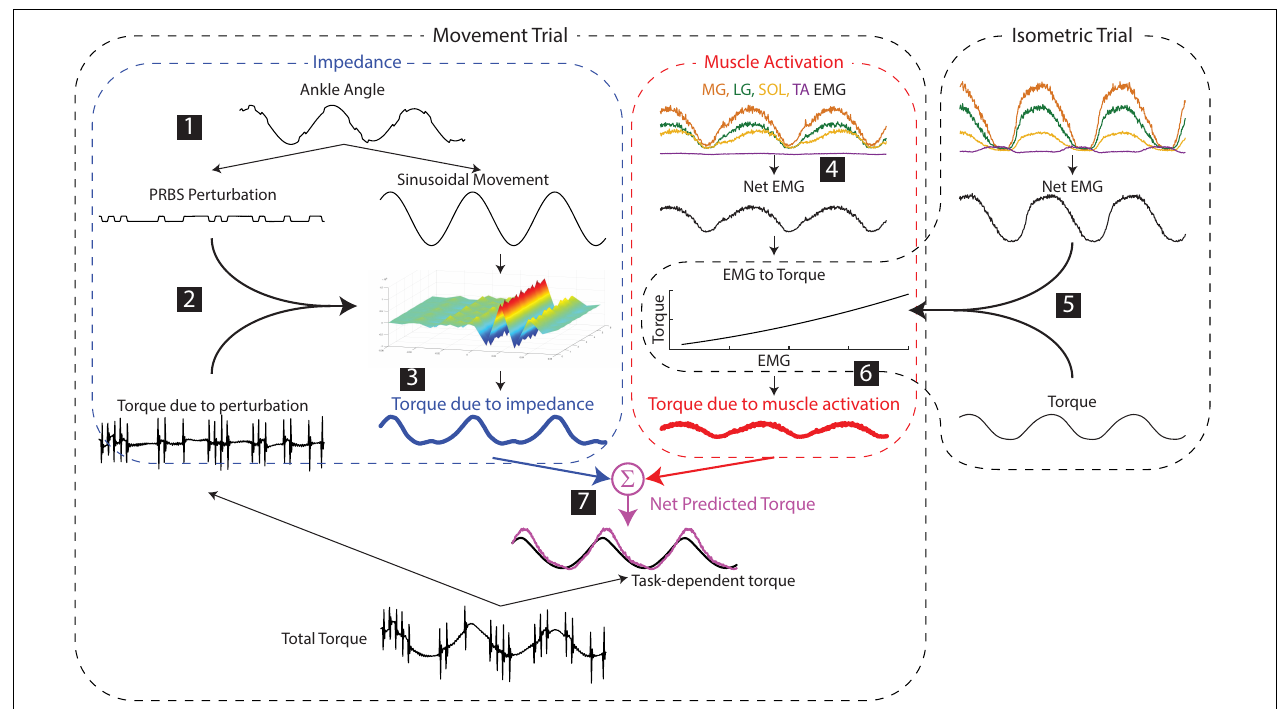
FIGURE 3 | Estimating the contributions of impedance and muscle activation to the net torque about the ankle. (1) Small pseudorandom binary sequence perturbations (PRBS) were superimposed on the larger sinusoidal movement. (2) Ankle impedance was estimated by fitting a time-varying impulse response function between the small perturbation and the resultant torque. (3) The torque due to the impedance was computed by convolving the larger sinusoidal movement with the estimated impedance. (4) The net muscle activity about the ankle was approximated as the difference between the average of the plantarflexor activity and the dorsiflexor activity. (5) The torque due to muscle activation was predicted by a static relationship between the net EMG and ankle torque, estimated from data collected in a separate isometric experiment for each subject. (6) The torque due to muscle activation in the movement trials was computed using this static relationship and the EMGs measured in the movement trial. (7) The net predicted torque was computed as the sum of the torques due to impedance and muscle